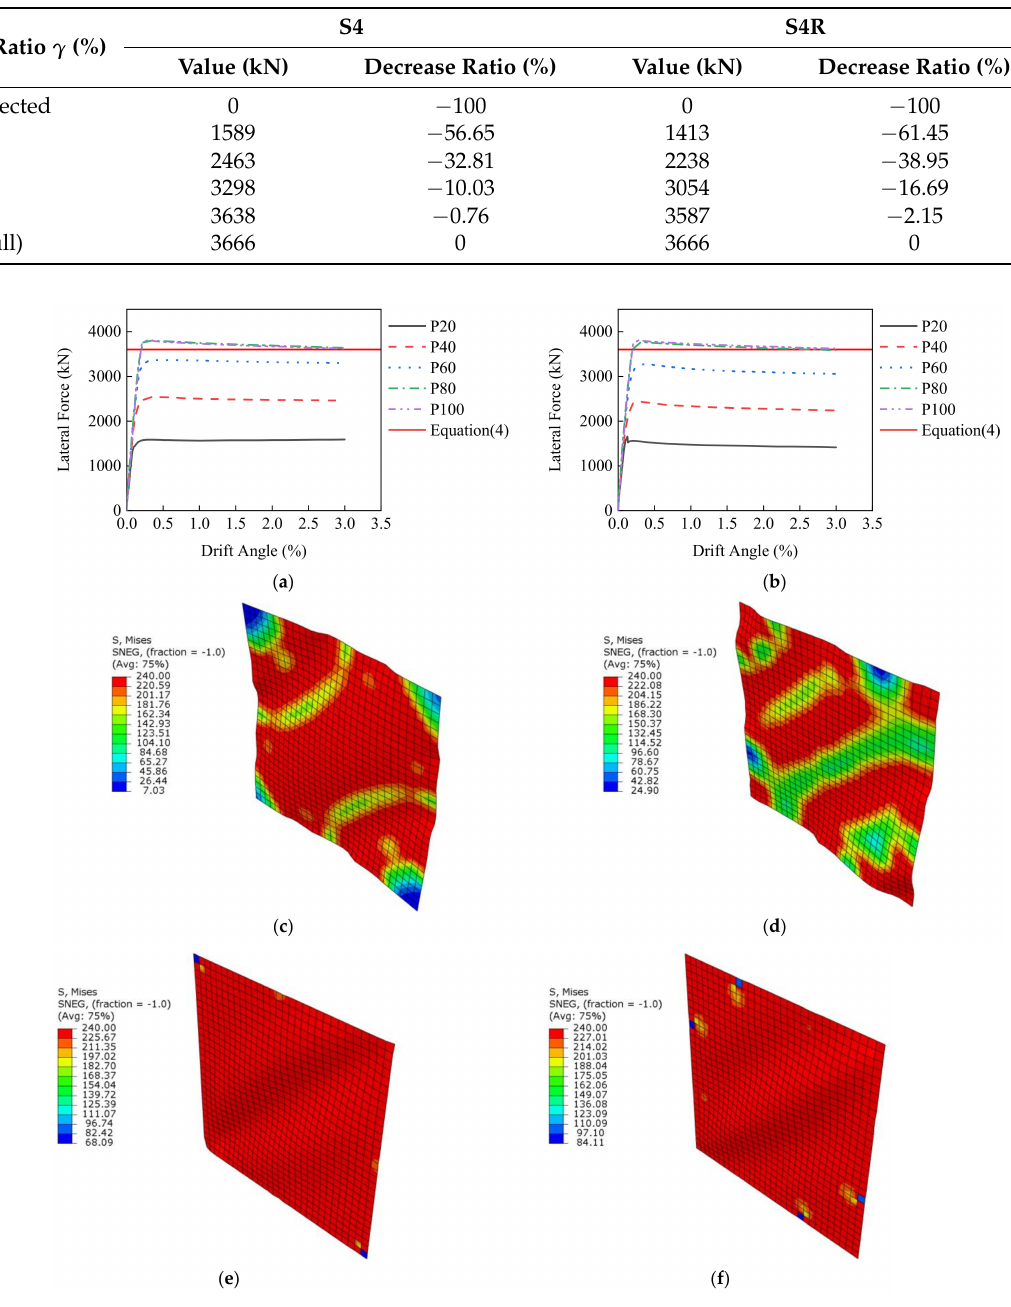
Figure 11. Load–displacement curves and stress distributions at 3% drift of S4 and S4R models: ( a ) S4; ( b ) S4R; ( c ) S4-P20; ( d ) S4R-P20; ( e ) S4-P80; ( f )